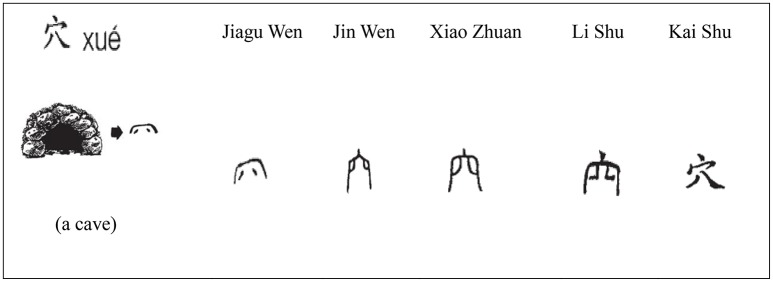
Example of semantic radical teaching materials (Li, 1999, p. 405).